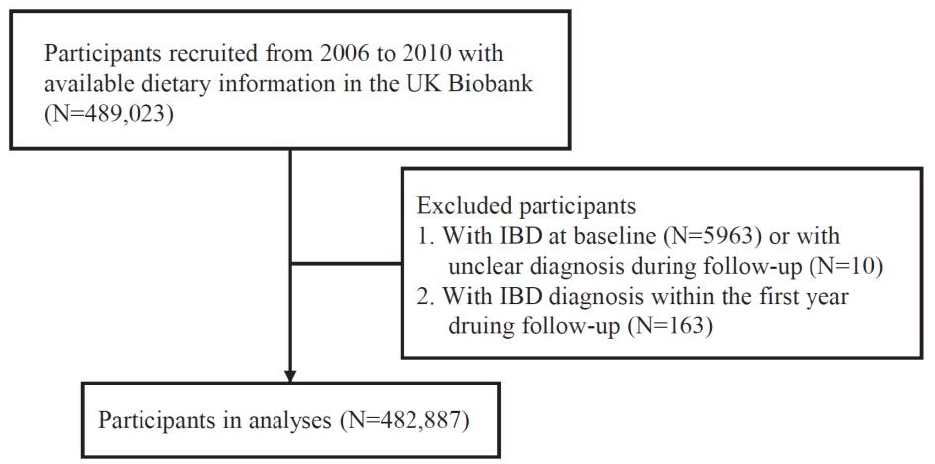
Figure 1. Flowchart of study participants in the UK Biobank. IBD, inflammatory bowel disease.